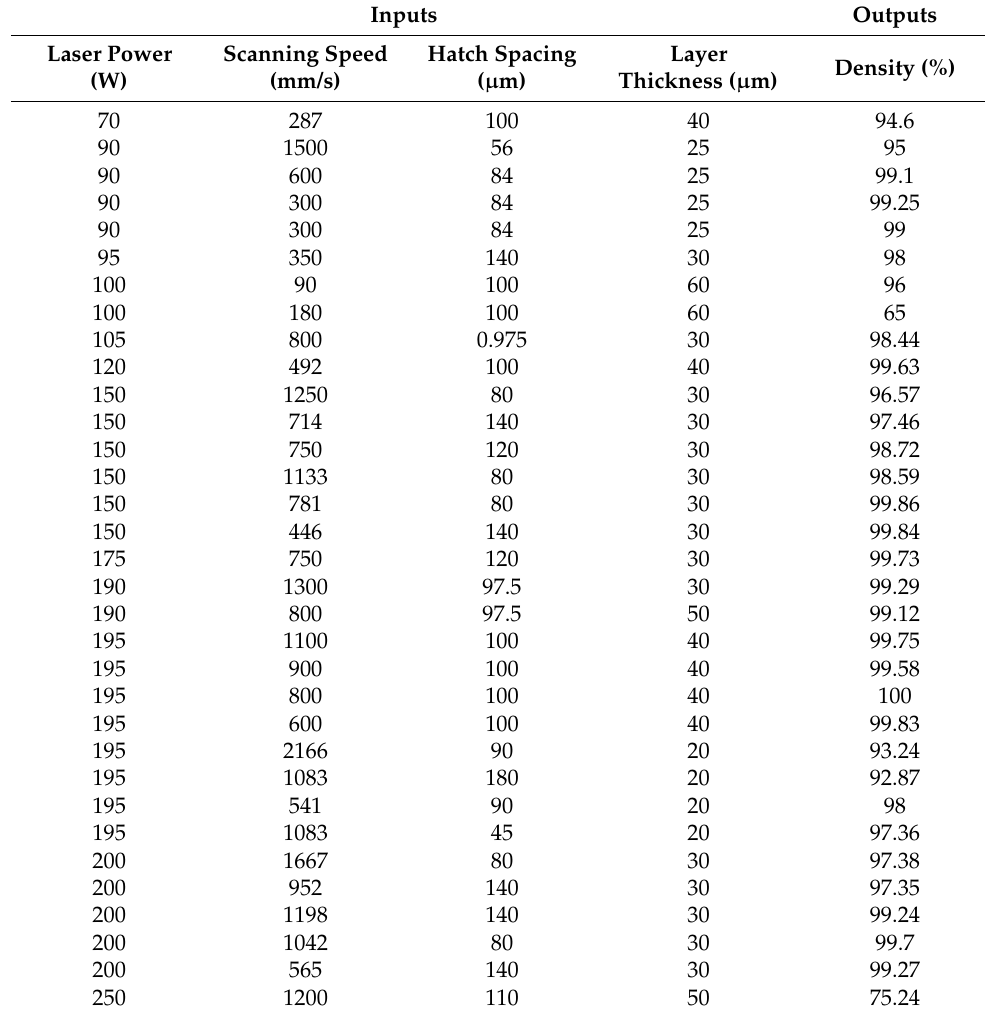
Table A1. Process parameters used to build ML